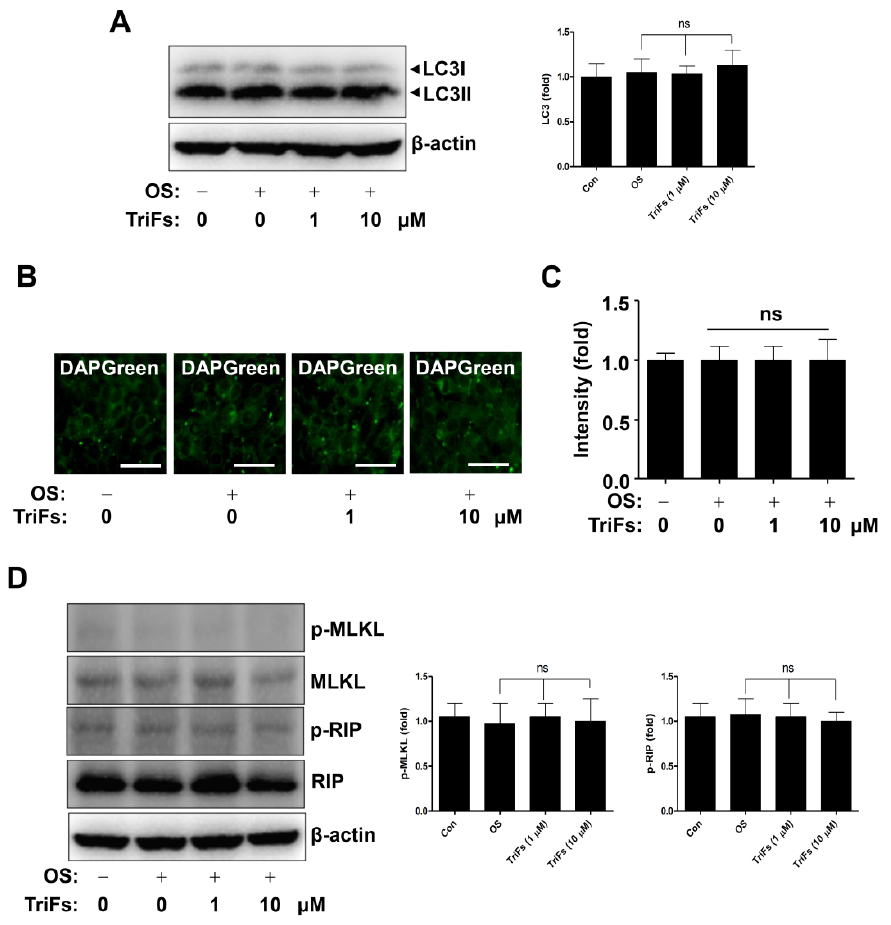
Figure 6. Osteogenic effects of trifloroside (TriFs) on autophagy and necroptosis. ( A ) Western blotting was used to analyze the levels of LC3I and LC3II. The values (fold) were normalized to β -actin and were displayed as a bar graph ( A ). ( B , C ) DAPGreen autophagy detection assay was used to determine autophagosome formation ( B ) and the values (fold) are displayed as a bar graph ( C ). ( D ) Western blotting was used to analyze the levels of p-MLKL, MLKL, p-RIP, RIP, and β -actin. The values (fold) were normalized to β -actin and were displayed as a bar graph. Data are presented as mean ± standard error of the mean (S.E.M.). Data shown are from three independent trials. ‘ns’, not significant. Scale bar: 50 µ